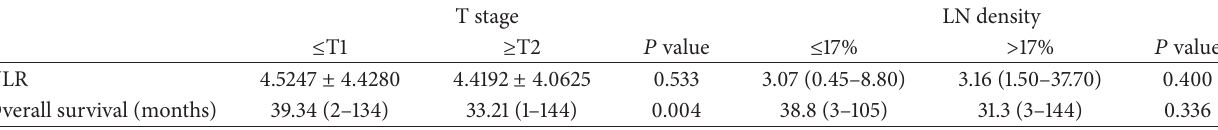
Table 2: NLR and overall survival rate according to T stage and LN density.